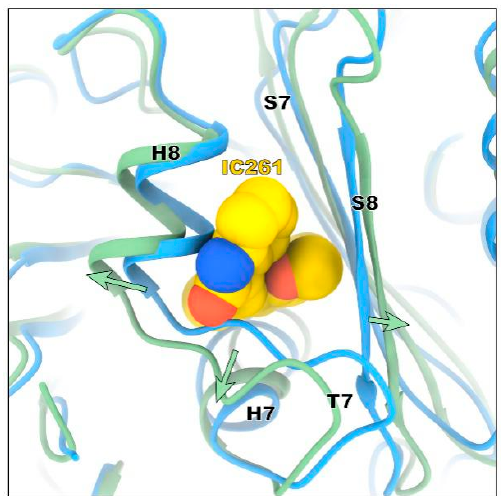
Figure 3. Conformational changes of the colchicine domain when tubulin binds to IC261. IC261 is shown in yellow sphericity. The position and shape of tubulin before and after binding to IC261 are represented by blue and green respectively.